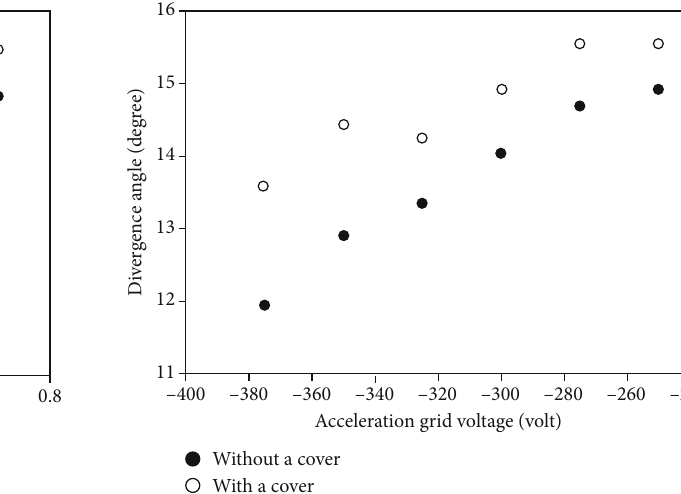
Figure 4: Variation of radial electric fi eld with and without the engine cover.